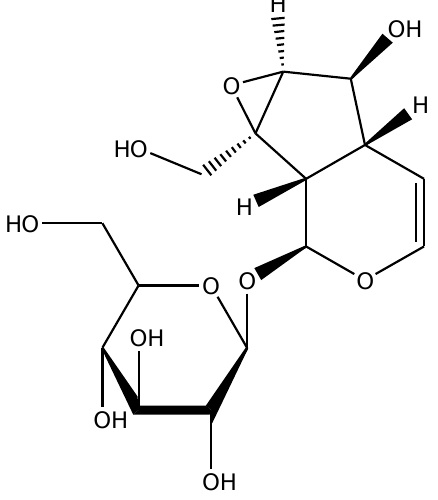
Figure 1. Chemical structure of catalpol.